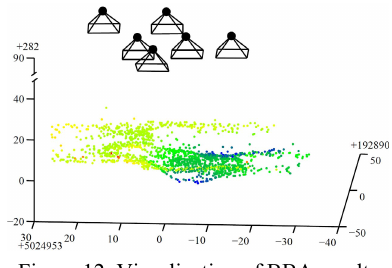
Figure 12. Visualization of BBA results